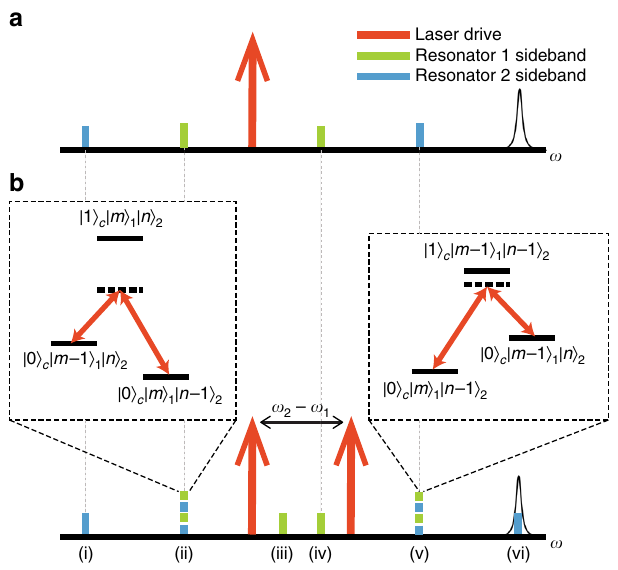
Fig. 2 Generating coupling between two resonators with two laser drives. a A single laser drive (red arrow) sent into the cavity produces four sidebands, two for each resonator. The laser is detuned from a cavity resonance on the right. b A second laser can be added to generate optical swapping. (ii) and (v) are overlapping sidebands of the two resonators. The insets indicate the analogy to state transfer in an atomic Λ -type system. The quantum number states are the photon occupation of the cavity, phonon occupation of resonator 1 and phonon occupation of resonator 2. Detuning from the intermediary state avoids losses due to light leaking out of the cavity. (iii) and (iv) are the unmatched sidebands of resonator 1 and (i) and (vi) are the unmatched sidebands of resonator 2. By adjusting the laser detuning, the sidebands (i − vi) can be separately aligned with the cavity resonance to interact with one resonator at a time or both at once. In the case shown here, the state of resonator 2 is swapped with the cavity, because sideband (vi) is aligned to the cavity. This fi gure is not to scale